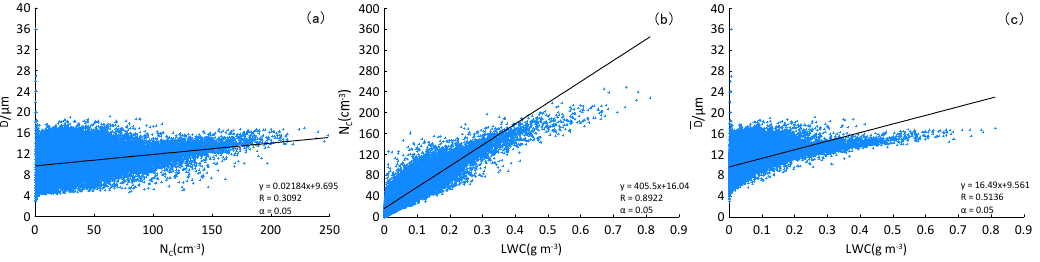
Figure 11. The correlation analysis of the two parameters in the Beilun district from 20:55 on 14 June to 7:20 on 15 June 2021. ( a ) D ( µ m) and N C (cm − 3 ), ( b ) N C (cm − 3 ) and LWC (g m − 3 ), ( c ) D ( µ m) and LWC (g m − 3 ).